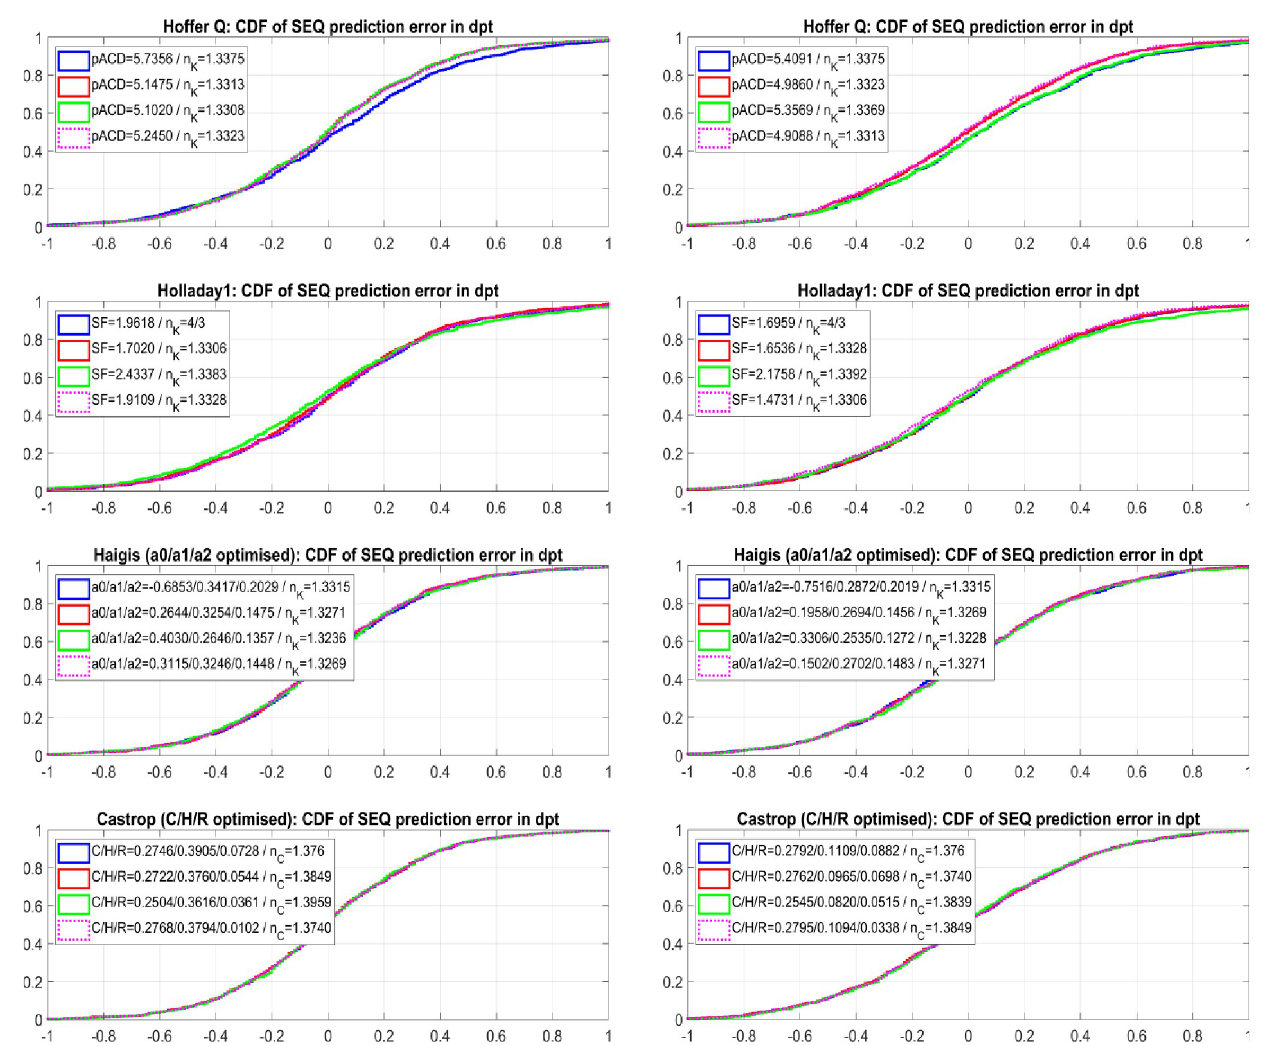
Fig 2. Cumulative density function (CDF on the Y axis) of prediction error (PE on the X axis, measured spherical equivalent refraction–formula predicted refraction) for the Hoffer Q, Holladay1, Haigis, and Castrop formula for dataset 1 (Hoya Vivinex, N = 888, left graph) and dataset 2 (Alcon SA60AT, N = 822, right graph). The ticks on the Y axis indicate the portion of cases in the dataset showing a PE less equal this mark. The steeper the slope around a PE = 0 the more cases within the respective limits. The number of eyes within PE limits (PE within ± 0.5 dpt) could be extracted from the graph by subtracting the respective CDF values at PE = 0.5 dpt and PE = -0.5 dpt. Formula constant optimisation was performed to minimise the sum of squared prediction errors PE: Situation A) (blue lines) refers to the ‘classical’ formulae with standard nK/nC values; with situation B) (red lines) the formula constants and nK/nC in the main part of the formula were varied for optimisation; with situation C) (green lines) the formula constants and nK/ nC in the main part of the formula were varied to minimise for PE and the PE trend error over corneal radius; with situation D) (dashed magenta lines) a standard optimisation was performed using the nK/nC value from situation B) derived from the other dataset in terms of a